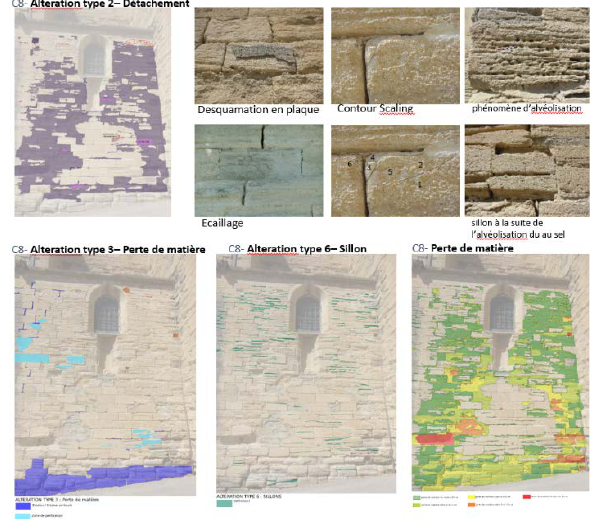
Figure 3. Maps of the detachments, corrosion and loss of matter.